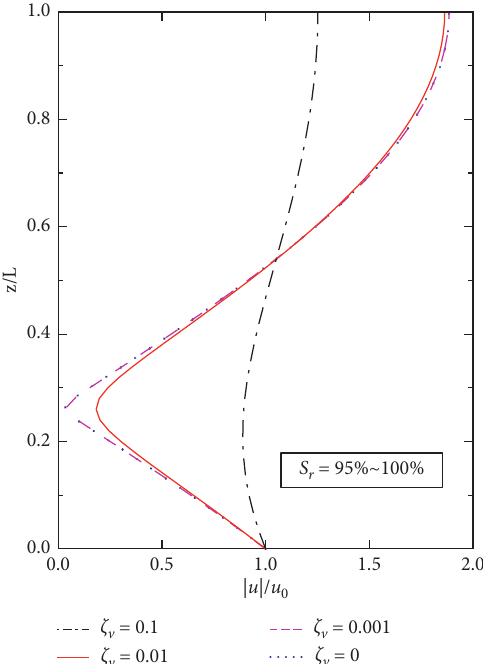
Figure 7: Distribution of amplification factor with depth (horizontal motion).